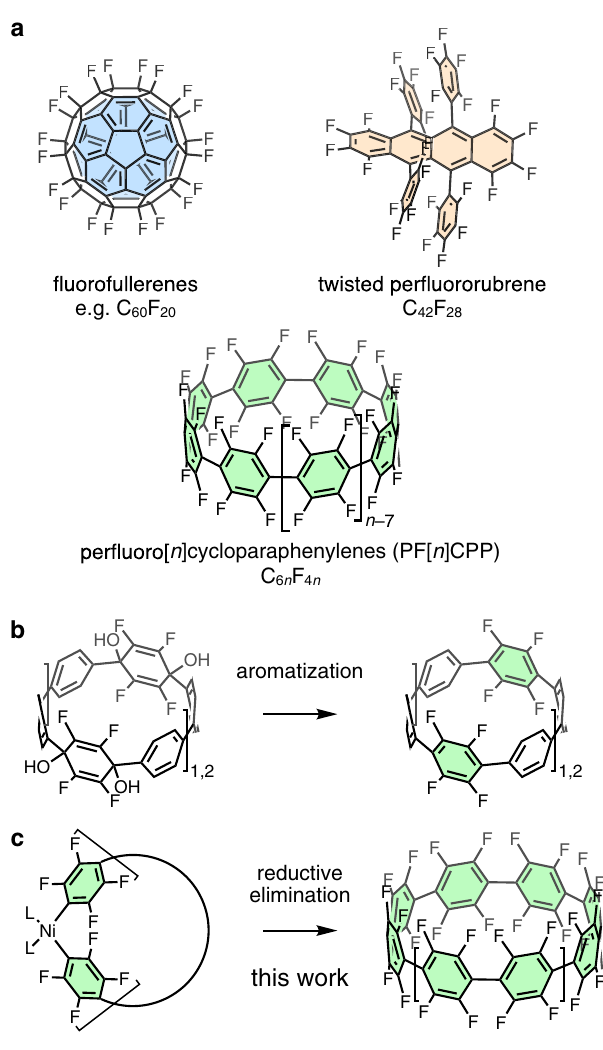
Fig. 1 Fluorocarbon molecules. a Structures of fl uorofullerenes, per- fl uororubrene, per fl uorocoranullene (top), and per fl uorocycloparaphenylenes (PFCPPs) (bottom). b A synthetic scheme of previously reported partially fl uorinated CPPs. c The synthetic strategy for PFCPPs (this